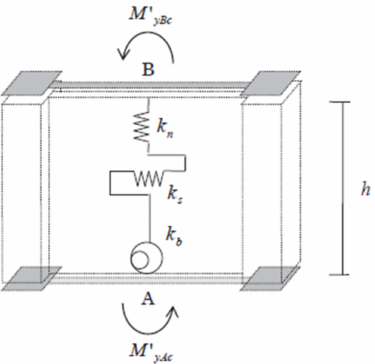
Figure 9. Wall element idealization in STERA_3D [26].